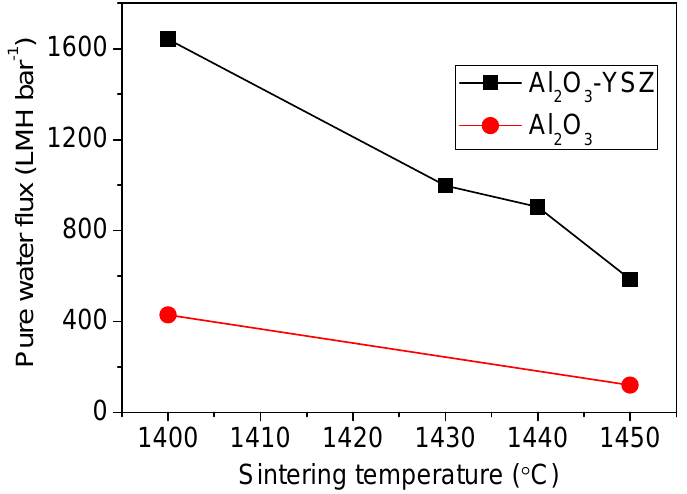
Figure 7. Pure water fluxes of the Al 2 O 3 -YSZ membranes. Water fluxes of a pure alumina membrane